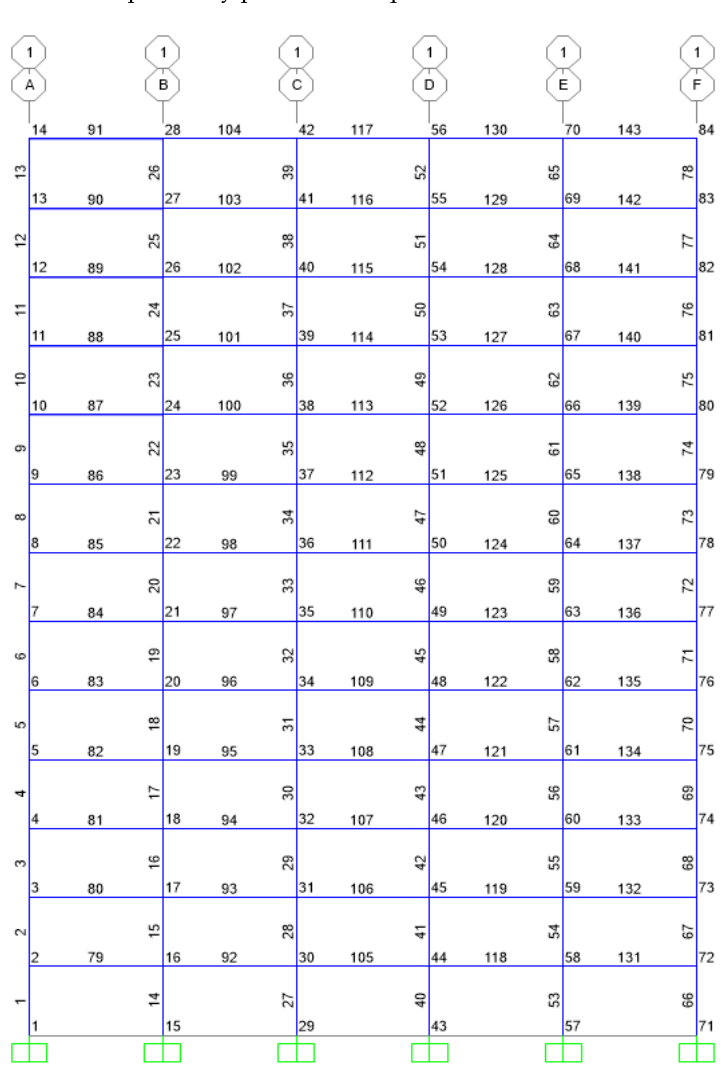
Figure 5. Numbering of elements and joints.